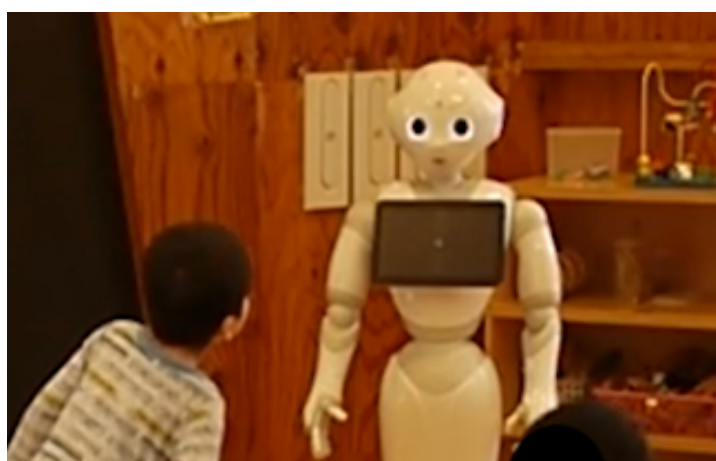
Figure 4. Japanese boy staring at Pepper’s tablet.